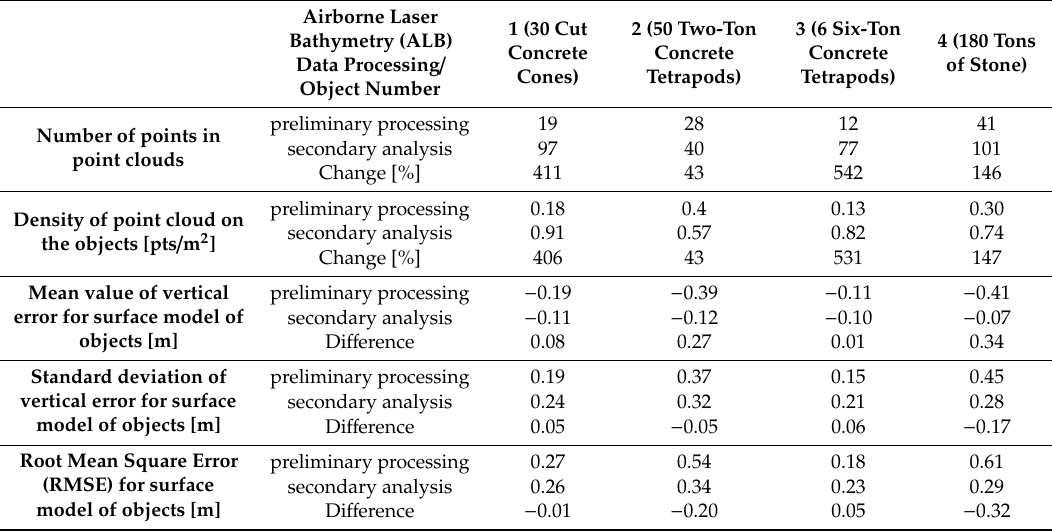
Table 1. Comparison of point clouds statistics and accuracy of seabed elevation model in the area of objects on the sea bottom. Calculations were made with respect to sonar data for the results of secondary analysis of full waveform on the